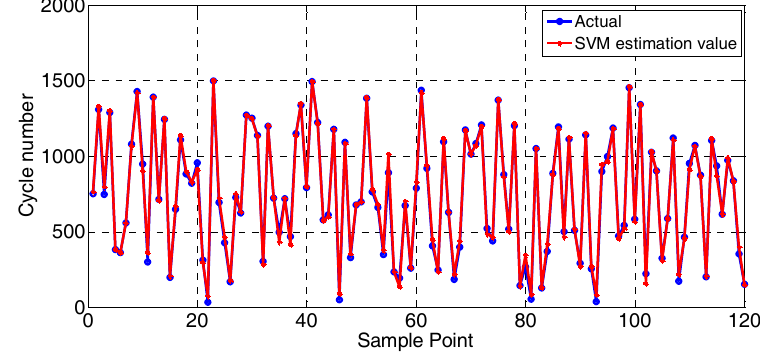
Figure 13. The cross-validation of the battery regression model.